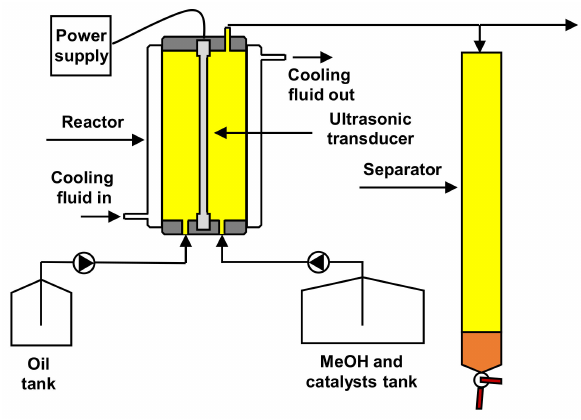
Figure 20. Ultrasonic continuous transesterification